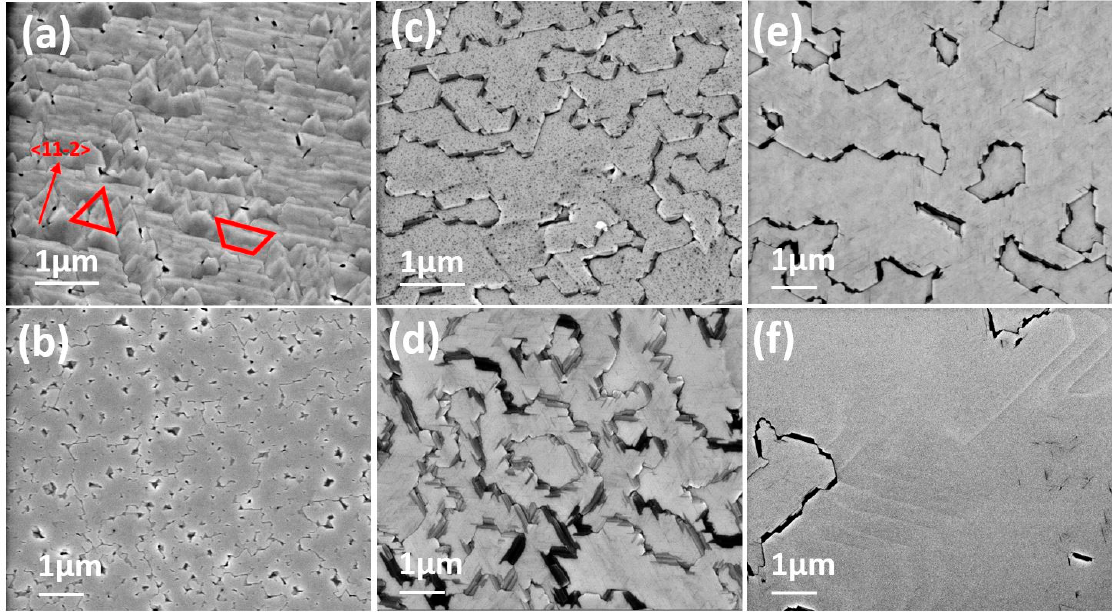
Figure 1. SEM micrographs: ( a ) 3C-SiC/AlN/Si(111) off axis —3 min of growth; ( b ) 3C- SiC/AlN/Si(111) on axis —3 min of growth; ( c ) 3C-SiC/AlN/Si(111) 4° off axis —20 min of growth (SiC thickness—300 nm); ( d ) 3C-SiC/AlN/Si(111) on axis —20 min of growth (SiC thickness—320 nm); ( e ) 3C-SiC/AlN/Si(110) on axis —20 min of growth (SiC thickness—320 nm); ( f ) 3C-SiC/6H-SiC on axis —20 min of growth.